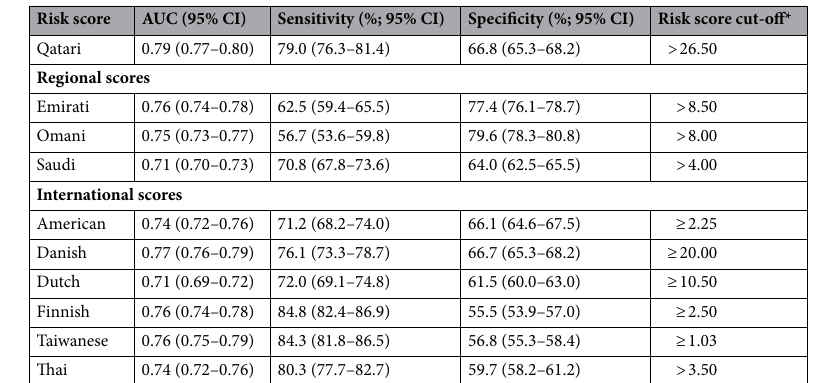
Table 3. Performance of three regional and four international diabetes risk scores in predicting diabetes mellitus among Qataris in 2020. AUC area under the curve; CI confidence interval. *For each risk score, the cut-off was recalculated to maximize sum of sensitivity and specificity for the Qatari sample.